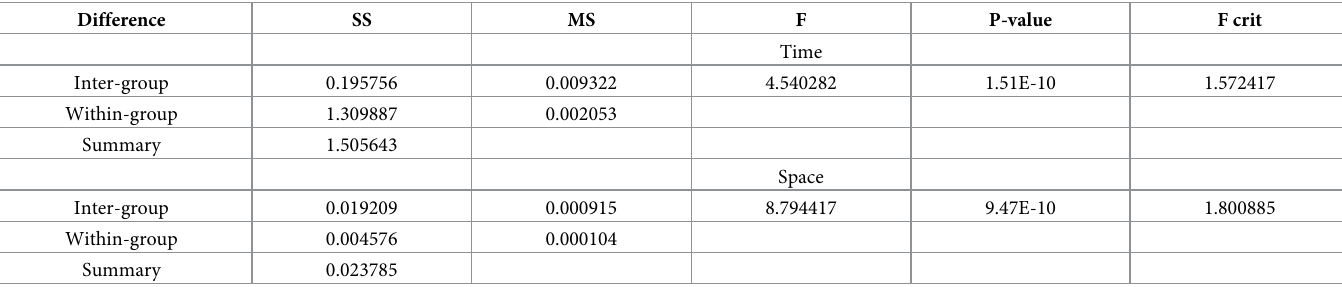
Table 1. Result of a single factor analysis of